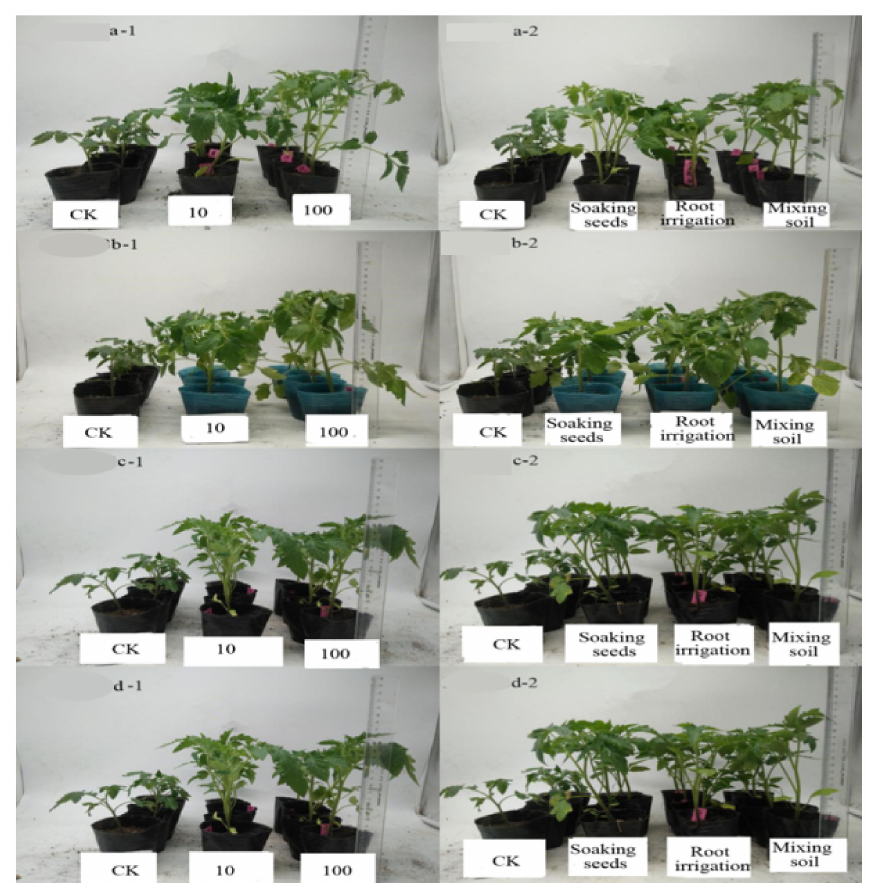
Figure 3. Effects of biocontrol bacteria with different concentrations and treatments on the growth of tomato seedlings. ( a ) Effects of WXCDD51 fermentation broth on the growth of tomato seedlings with different concentrations (1) and different treatments (2). ( b ) Effects of WXCDD105 fermentation broth on the growth of tomato seedlings with different concentrations (1) and different treatments (2). ( c ) Effects of Ba fermentation broth on the growth of tomato seedlings with different concentrations (1) and different treatments (2). ( d ) Effects of Bs wy-1 fermentation broth on the growth of tomato seedlings with different concentrations (1) and different treatments